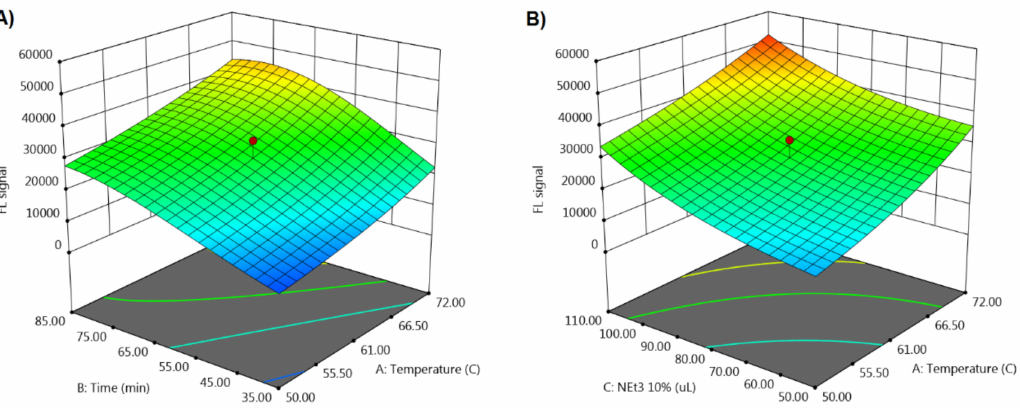
Figure 3. 3D graphs: ( A ) FL signal = f (time, temperature) and ( B ) FL signal = f (Et 3 N 10%,